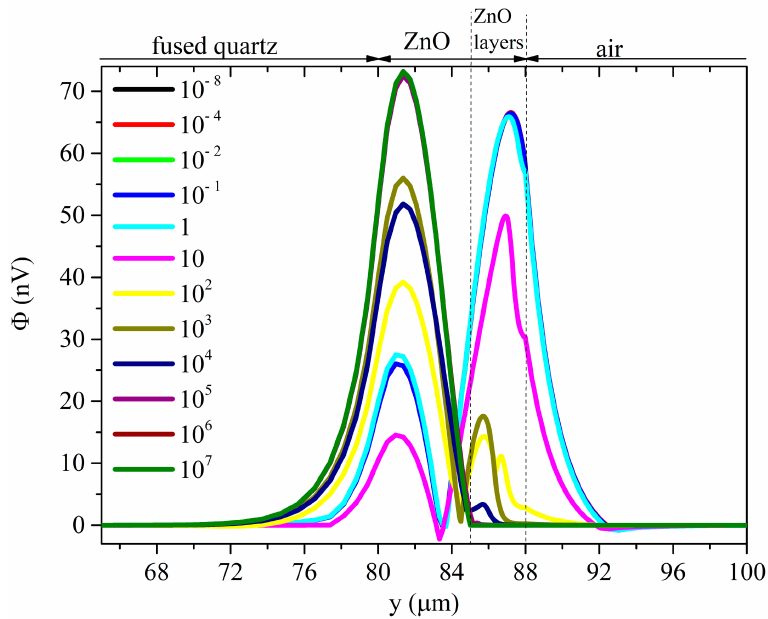
Figure 17. The electric potential distribution under the Sezawa mode at some conductivity values, under top illumination, and when δ UV = 200 nm.